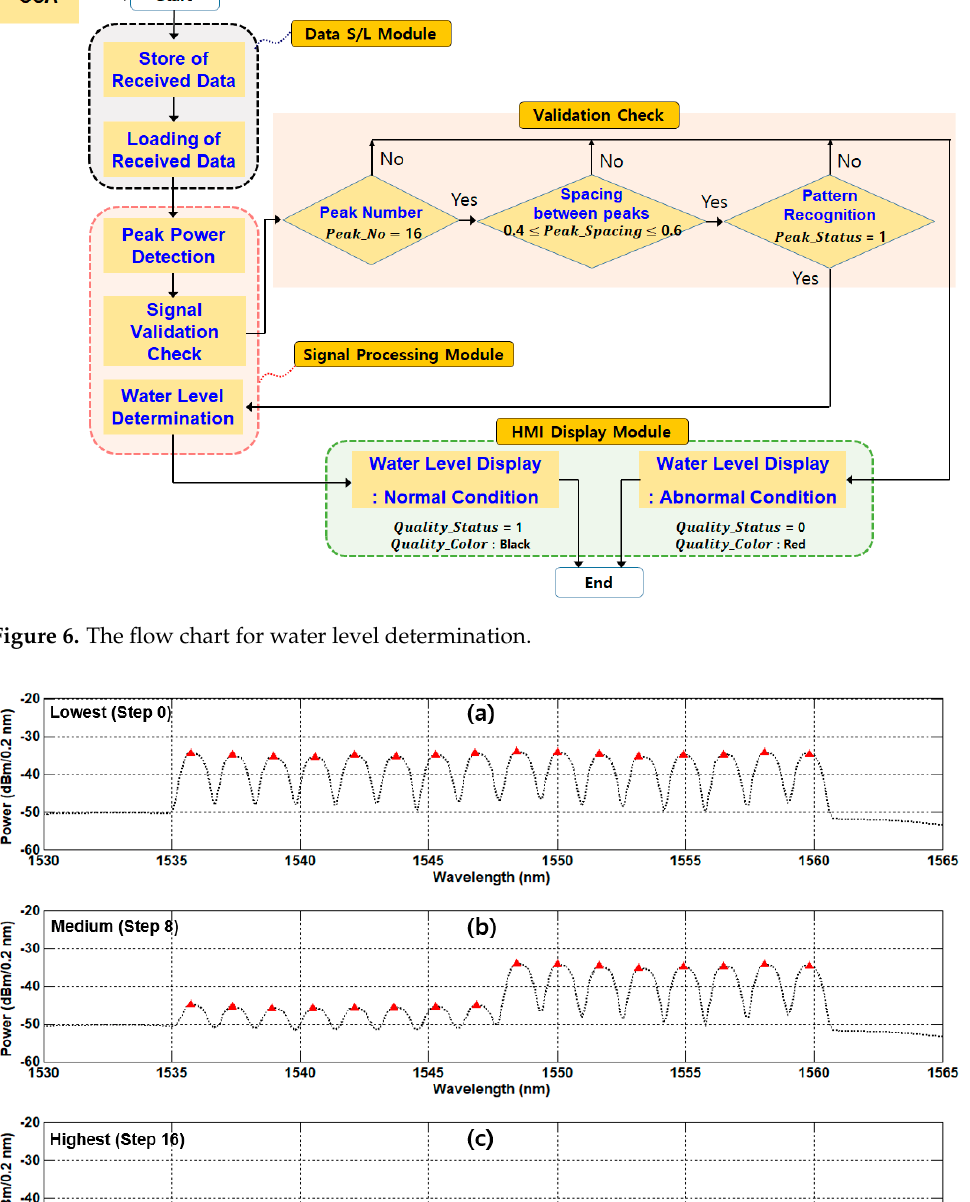
Figure 6. The flow chart for water level determination.